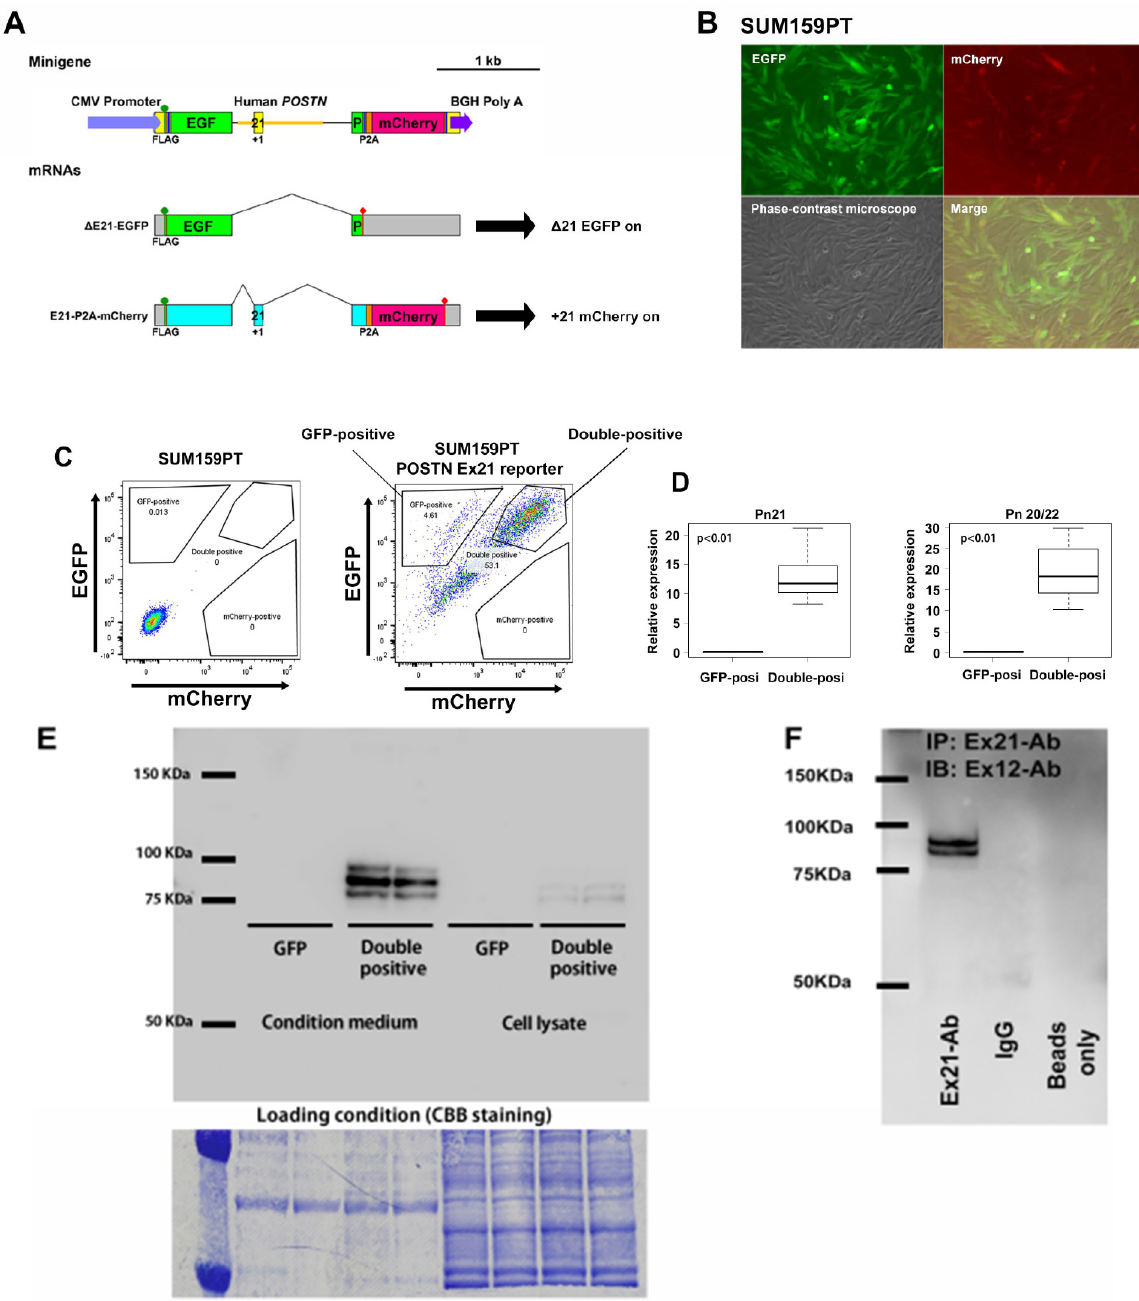
Figure 1. Identification of Pn-secreting SUM159PT cells. ( A ) Construction of fluorescence-based alternative splicing reporter minigenes for Pn exon 21. A genomic fragment from intron 20 to intron 21 of the POSTN gene is inserted into an artificial intron in EGFP cDNA. mCherry cDNA is connected downstream of the EGFP in another reading frame. EGFP and mCherry are expressed when POSTN exon 21 is skipped and included, respectively. ( B ) Images of SUM159PT cells with the Pn-splicing reporter. ( C ) Flow cytometry analysis of GFP and mCherry expression on SUM159PT tumor cells. SUM159PT cells with (right) or without (left) the Pn-splicing reporter. Double positivity indicates the fraction positive for both GFP and mCherry. ( D ) Pn mRNA expression in the cells from the GFP- or double-positive fraction. Pn21 and Pn20/22 indicate endogenous Pn mRNAs with exon 21 and without exon 21, respectively. n = 10. ( E ) Pn protein expression in conditioned media or cell lysates from GFP- or double-positive cells. Pn was detected with an antibody recognizing exon 12. Three bands indicate ASVs of Pn. Loading condition was confirmed with CBB staining. ( F ) Immunoprecipitation (IP) studies for Pn exon 21 in conditioned media from double-positive SUM159PT cells. Pn was detected with the antibody recognizing exon 12.